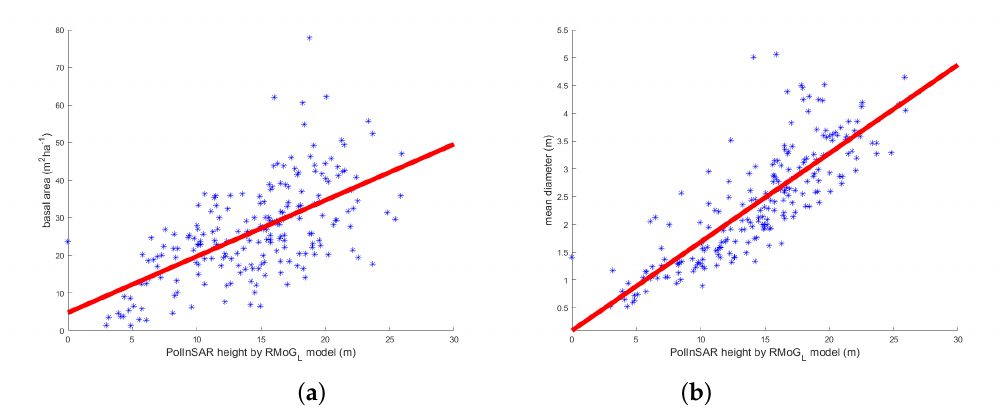
Figure 11. The relationship ( a ) between the PolInSAR height from the RMoG L model and the basal area with R 2 = 0.61 and ( b ) between this height and the mean diameter with R 2 = 0.81 in